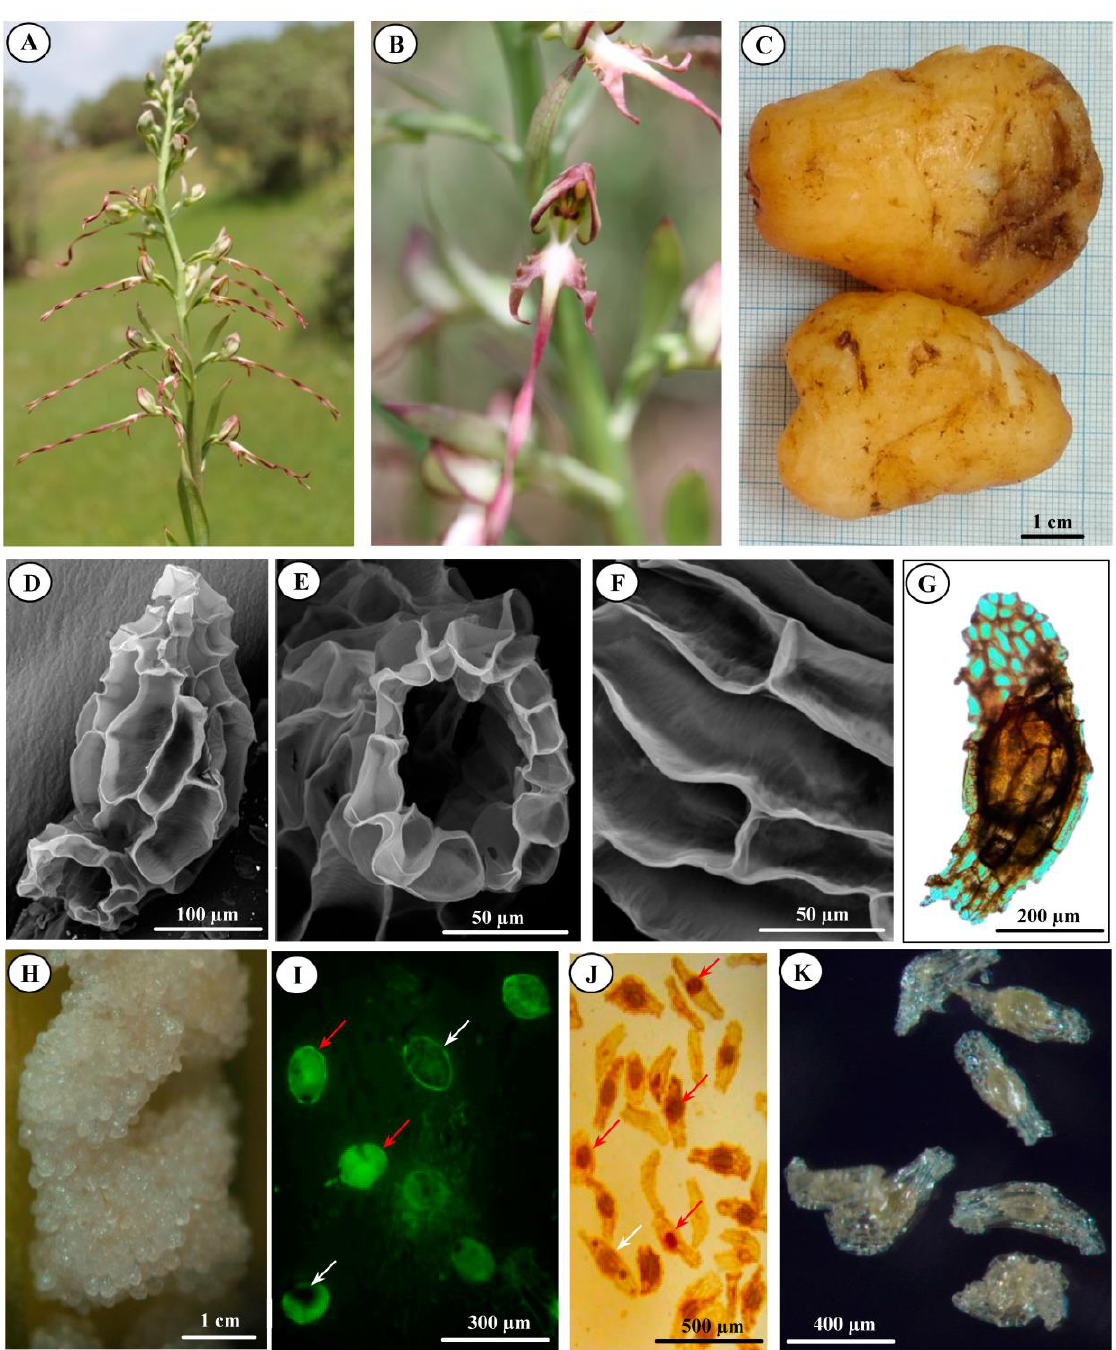
Figure 1. ( A , B ) Inflorescence and flower morphology; ( C ) underground tuber morphology; ( D – F ) scanning electron microscopy (SEM) micrograph of seed testa micromorphology; ( G ) light microscopy of seed color and structure; ( H ) immature white seed within the capsule; ( I , J ) fluorescein diacetate (FDA) and tetrazolium chloride (TTZ) analyses of seed viability, respectively (red and white arrowheads show the viable and dead or deeding seeds, respectively); ( K ) seed with softened testa after disinfection with sodium hypochlorite.